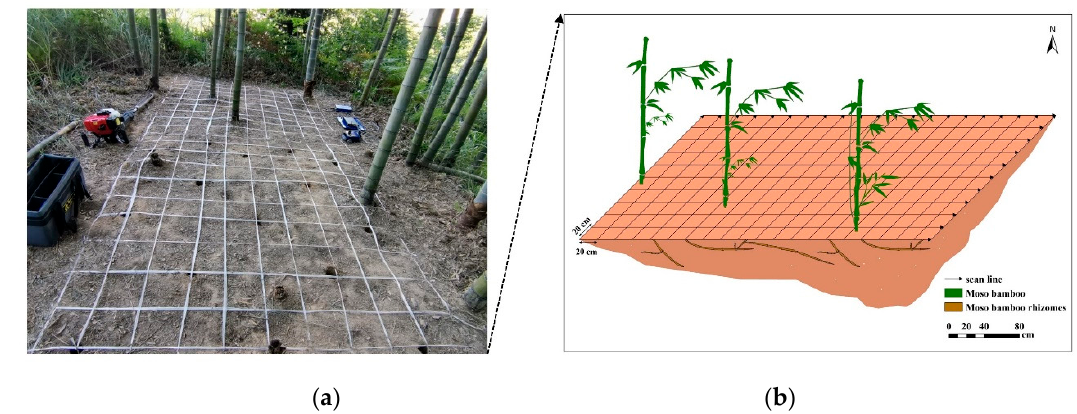
Figure 3. ( a ) Survey site for ground-penetrating radar (GPR) analysis of moso bamboo rhizomes, including ropes representing the orthogonal survey grid. ( b ) 3D schematic of the sample plot, including the layout and orientation of scan survey lines.